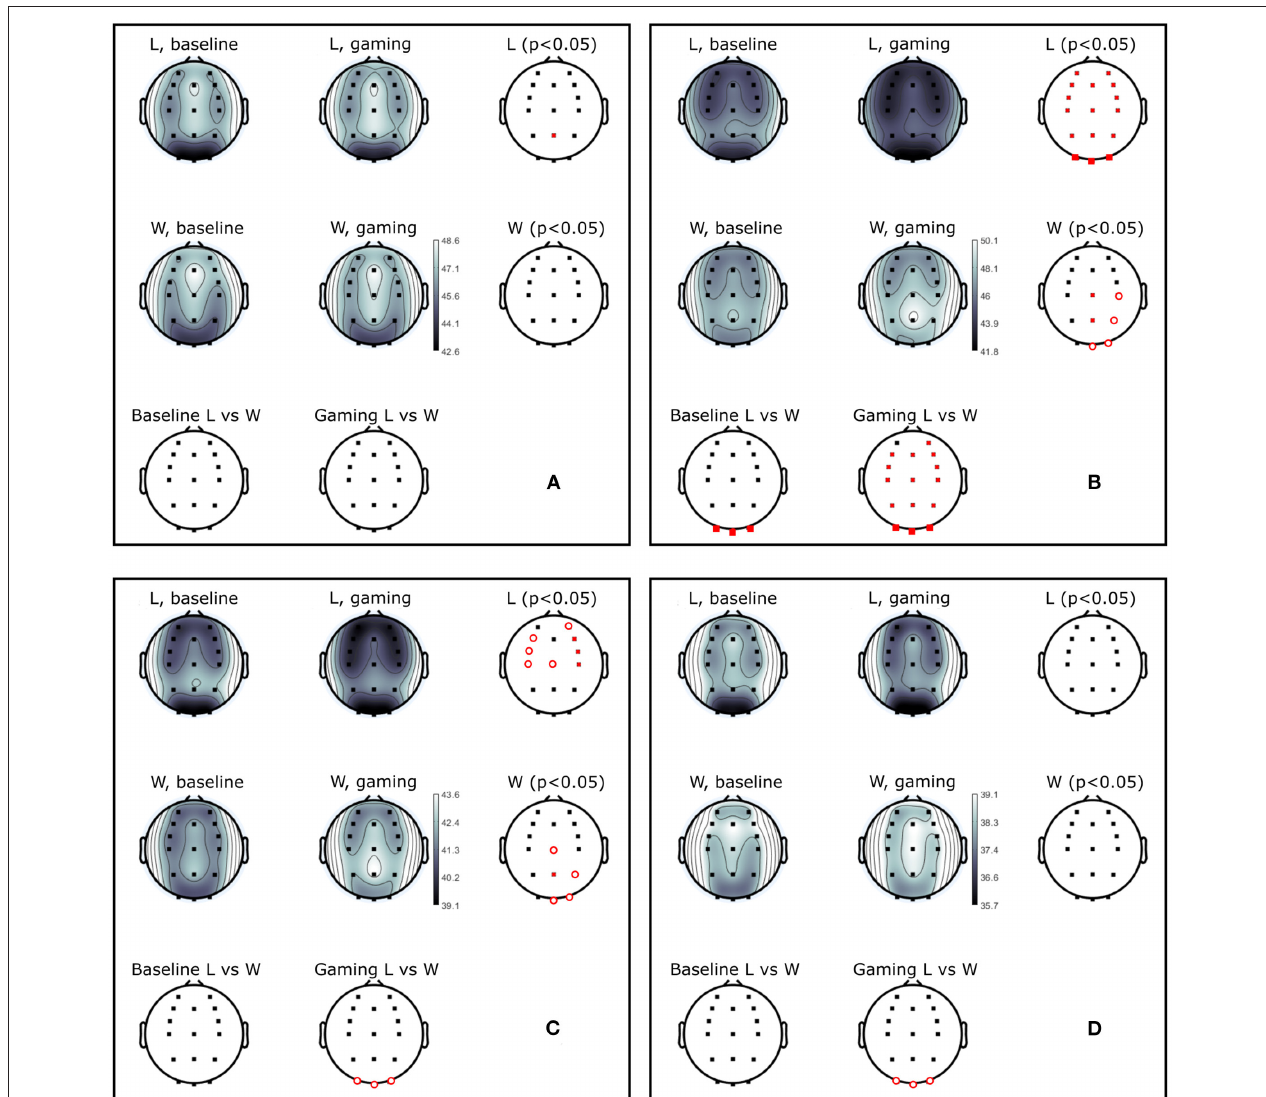
FIGURE 10 | Power (dB) during baseline and competitive gaming for L and W groups, in (A) theta (4–7Hz), (B) alpha (8–12Hz), (C) beta 1 (13–20Hz), and (D) beta 2 (21–30Hz) bands. Significant differences from permutation testing shown in red ( p < 0.05, open circles–before; closed–after FDR correction).